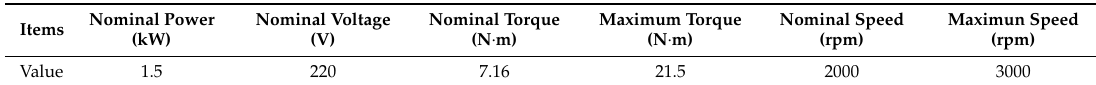
Table 9. Specifications of the selected servo motor.